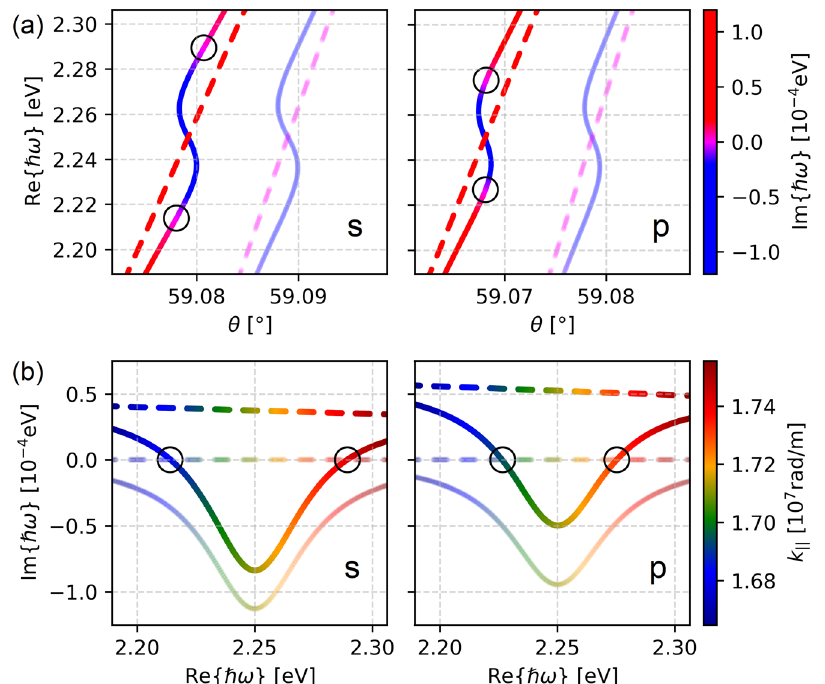
Figure 9: Results of the complex eigenfrequency analysis using transfer matrix method for the gain medium slab waveguide – the same as in Section 2.4 – with the coupling prism (opaque contours/ intense colors) and without the coupling prism (semitransparent contours/faint colors): trajectories of the poles of the re fl ection coef fi cient as a function of the